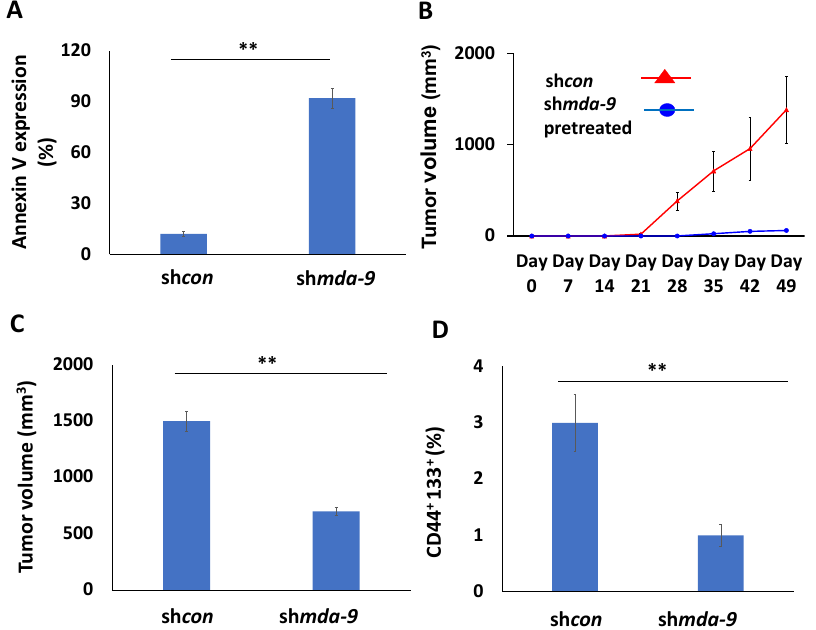
Figure 2. MDA-9 regulates survival and tumorigenic potential in PCSCs. ( A ) E ff ect of mda-9 kd in promoting PCSCs cell death analyzed by Annexin V assays. ( B ) E ff ect of mda-9 kd on PCSC tumorigenicity ( n = 10). ( C ) E ff ect of intra-tumoral mda-9 kd on tumorigenicity ( n = 10). ( D ) PCSC populations in tumors following intra-tumoral mda-9 kd. The bars represent SEM. ** p < 0.01 using the Student’s t -test and